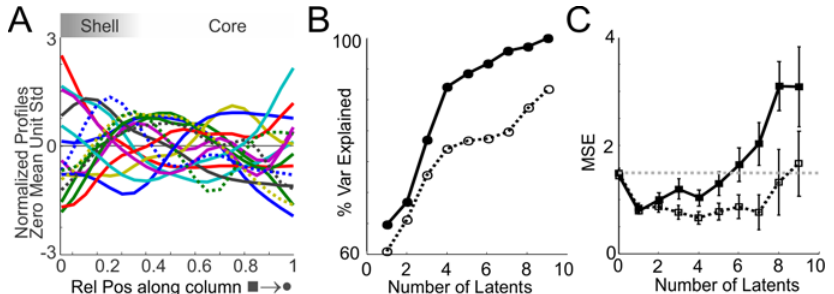
Fig 4. PLS Regression Suggests Complex Cryptic Organisation. (A) Normalised profiles (zero mean and unit variance) representing the numbers of cells; spread of cells and normalised P t representing topological and topographical order for all groups (WT, P6, P12 and β 2 -/- ). Colour coding is arbitrary except that the β 2 -/- group are dashed lines. (B) PLS regression; the degree of variance within A is increasingly explained by an increasing number of latents. Curves represent the explained variance for the combined WT, P6 and P12 groups (solid line) and all groups combined together (dashed). (C) Cross-validation error (Mean Squared Error — MSE) as a function of the number of latents retained in the model. WT, P6 and P12 groups (solid line) and all groups